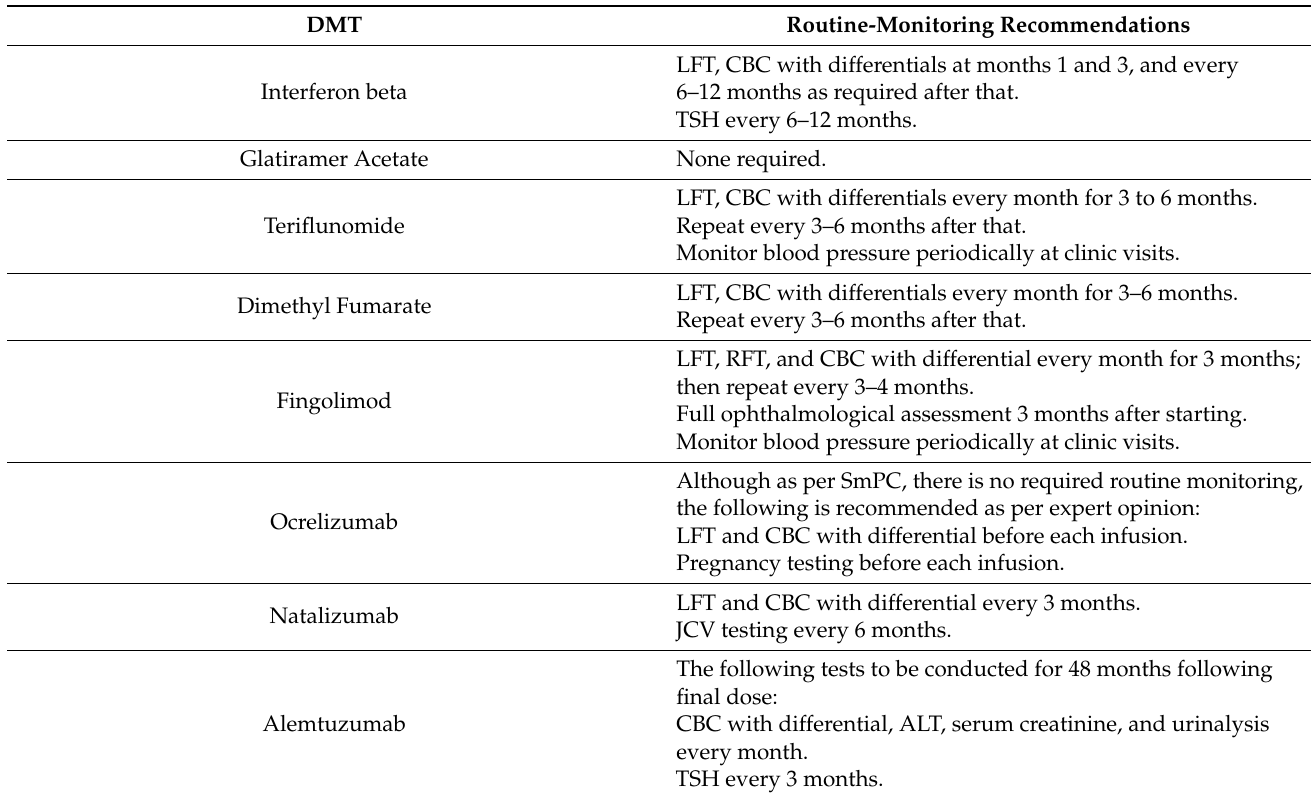
Table 3. Disease-modifying therapy (DMT)-specific routine-monitoring